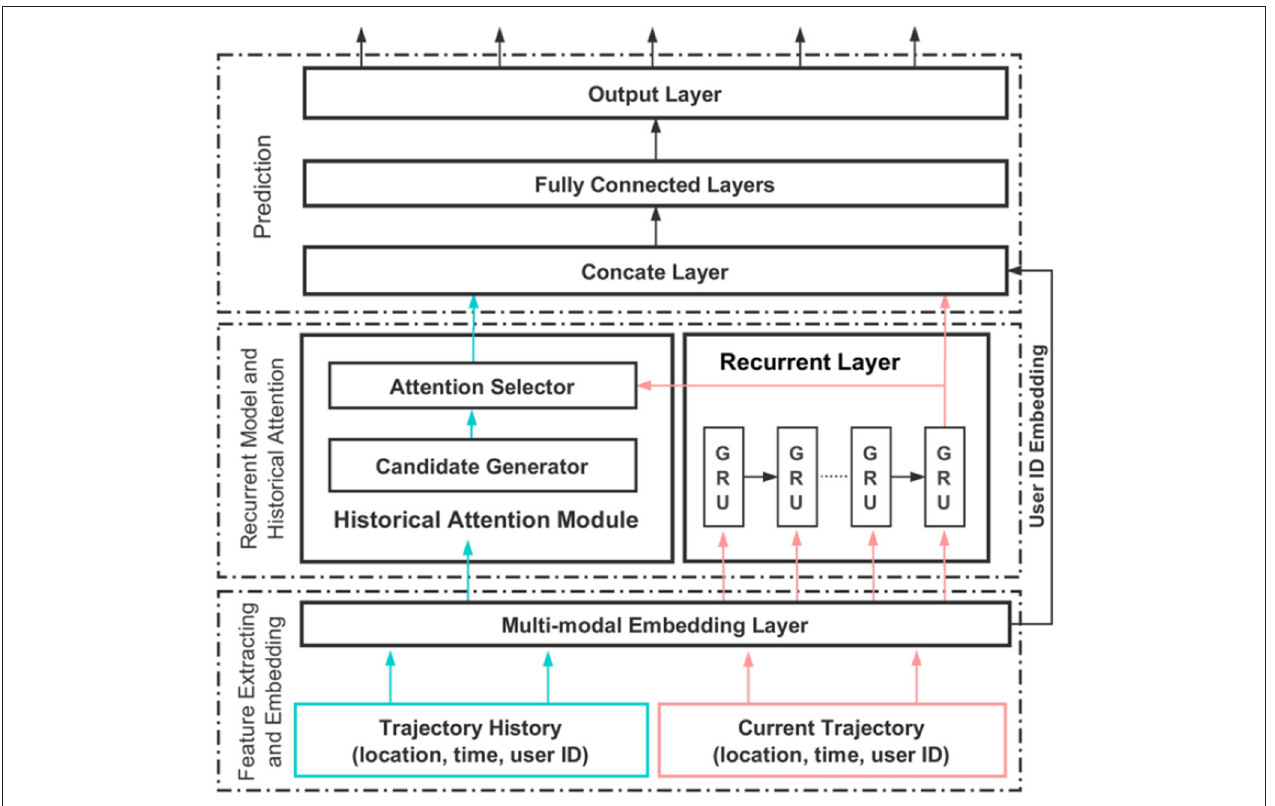
FIGURE 2 | DeepMove’s main architecture (Feng et al.,